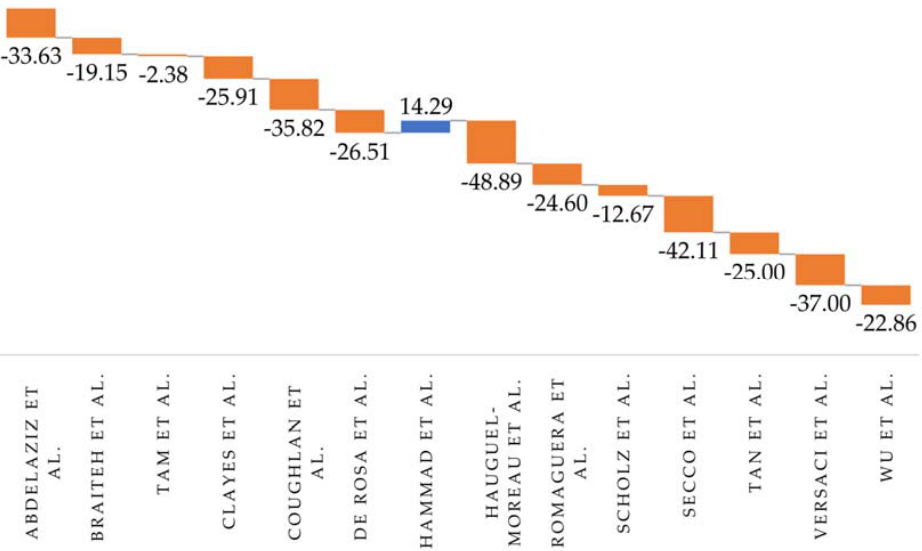
Figure 2. Percentage variation of the number of patients presenting daily during the pandemic compared to the period before.